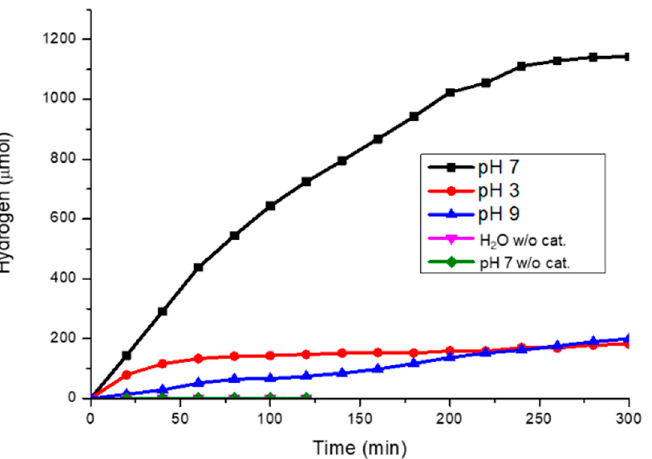
Figure 8. Comparison of visible light-irradiated hydrogen production of Nafion-coated Pt-TiO 2 ( 2 ) at different pH values in the presence of 0.1 mM SnP 6+ .